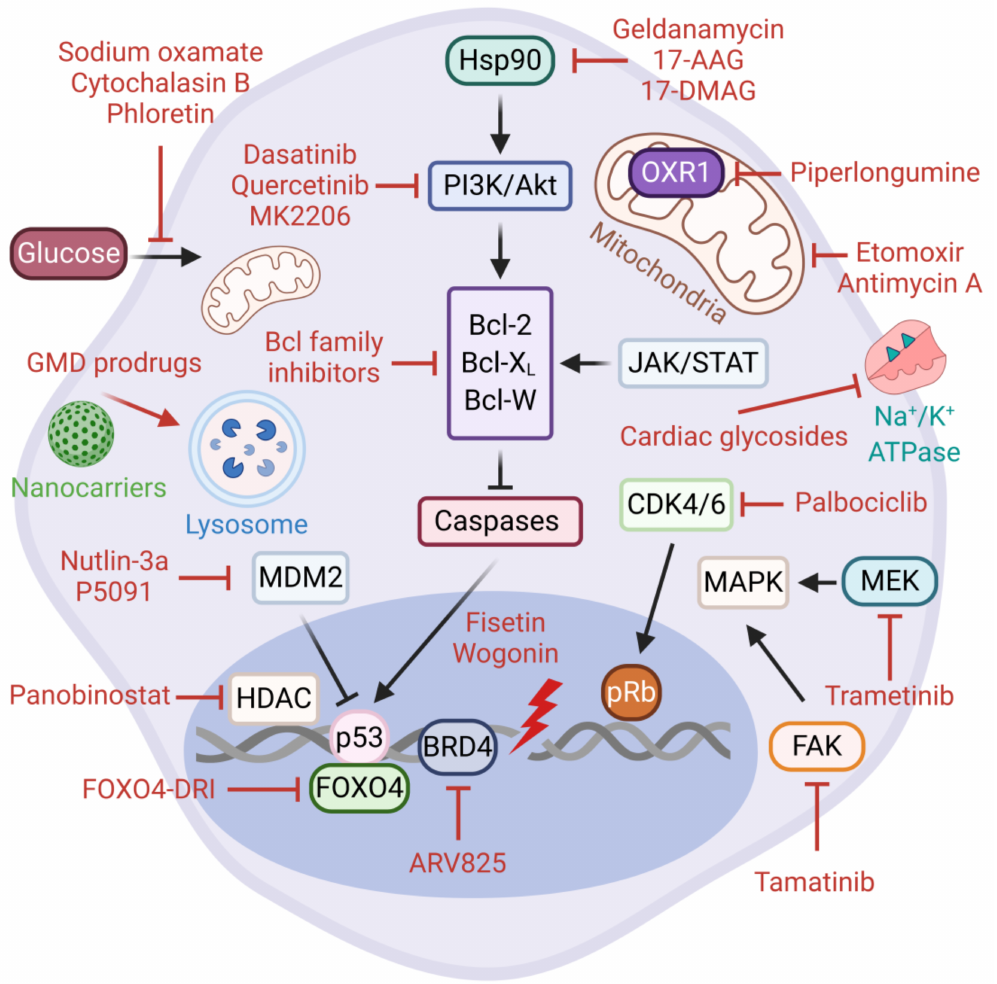
Figure 3. Senolytic therapies. Senolytics mainly target the Senescent Cell Anti-apoptotic Pathways (SCAPs). The SCAPs are activated to protect senescent cells from apoptosis triggered by any form of pro-apoptotic insults, including the SASP. The most common SCAPs are Hsp90, Bcl-2 family proteins, p53, and the PI3K/Akt/mTOR pathway. Several senolytic agents identified to date are depicted. Directed targeting of senescent cells is achieved by the nanoparticle-based delivery of